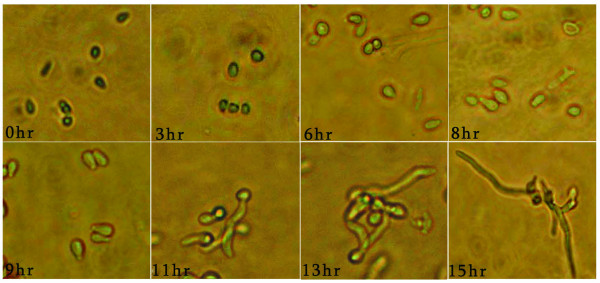
Morphological transitions during conidial germination of T. rubrum. Dormant conidia were introduced into Sabouraud liquid medium and incubated at 28°C. 0 hr is dormant conidia. The 0 hr to 15 hr images were taken at the indicated time-points, and show the morphological transitions with time.